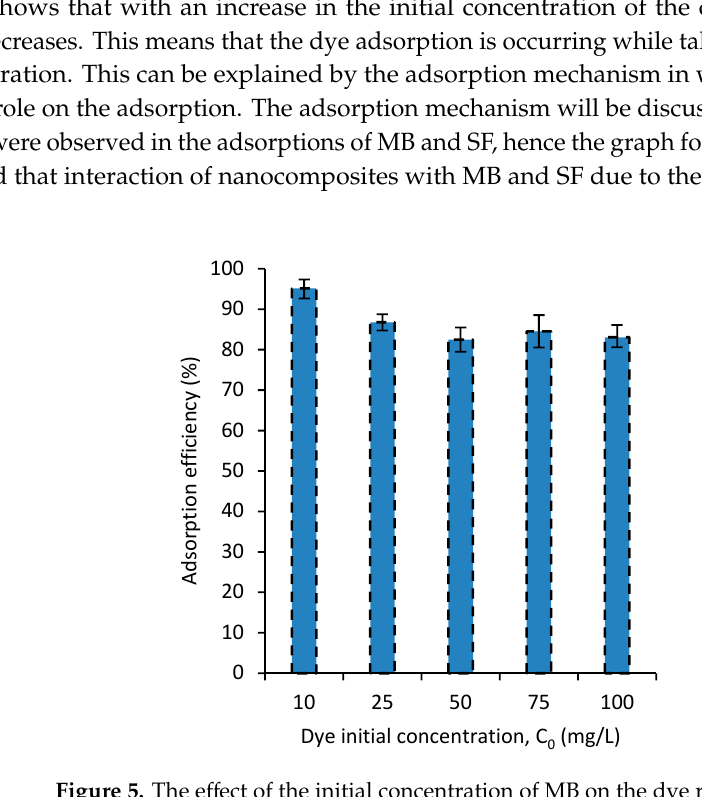
Figure 5. The e ff ect of the initial concentration of MB on the dye Figure 5. The effect of the initial concentration of MB on the dye removal.